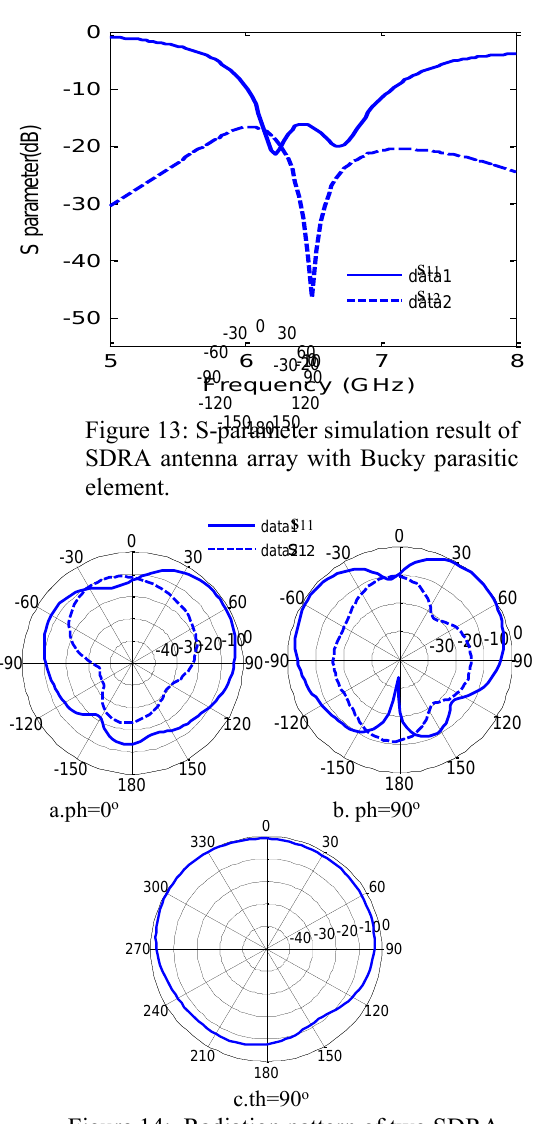
Figure 14: Radiation pattern of two SDRA